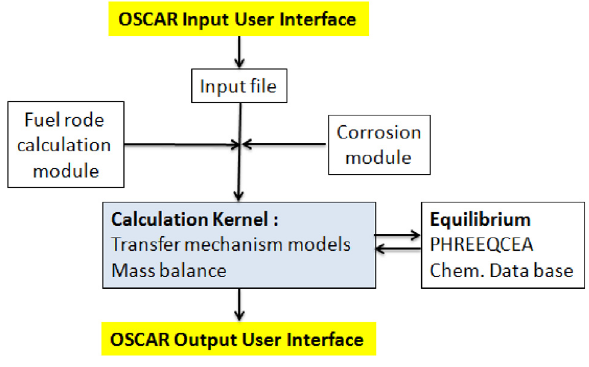
Fig. 2. Structure of the OSCAR code.